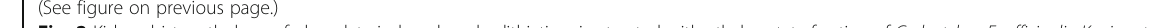
Table 2 Effect of ethyl acetate fraction of C. dactylon , E. officinalis , K. pinnata , and B. nutans on different urine parameter ratios of glyoxalate induced nephrolithiatic mice Dose (mg/kg) Ethyl acetate fraction of C. Vehicle control Negative